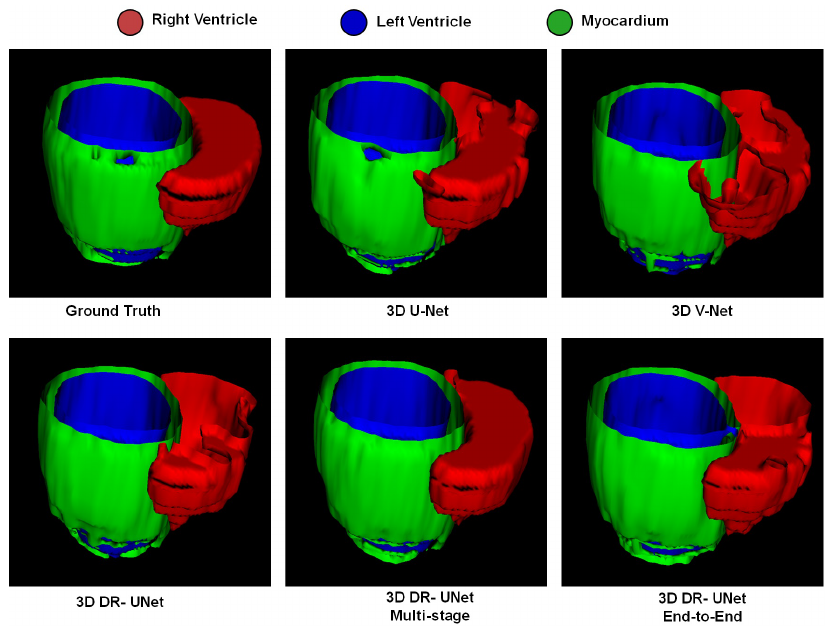
Figure 6. The surface mesh outputs produced by the different networks on a random test subject at the ED phase of the heart. The colors red, green and blue indicate RV, MYO, and LV respectively. Comparison with State-of-the-art Methods: We further compared our proposed method with two other similar localization and segmentation methods including, Yang et al. and